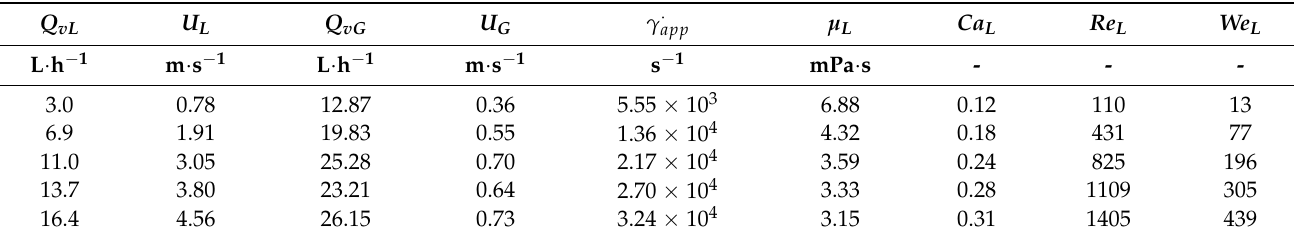
Table 3. Hydrodynamic parameters of the two-phase flow in the expansion channel of the microfluidic device CX-E-600 for several flow conditions using the model solution